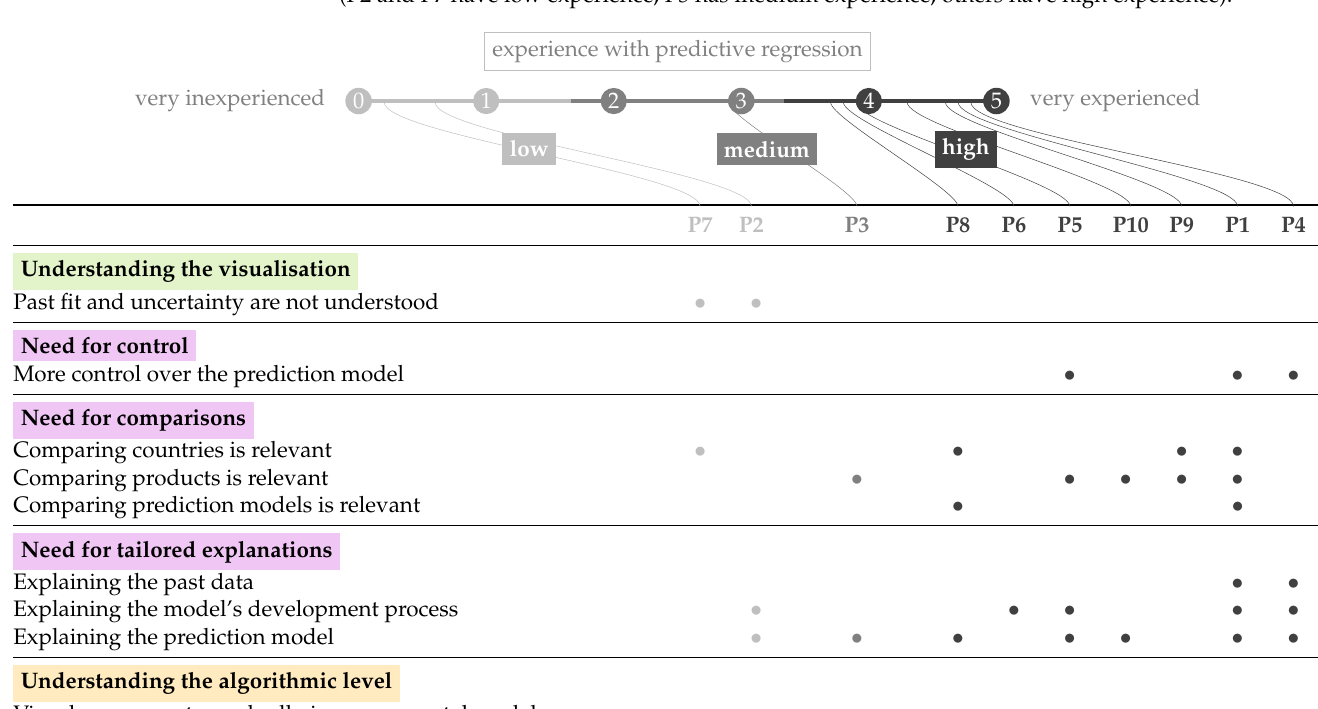
Table 2. Some topics raised by the participants, ordered by their experience with predictive regression (P2 and P7 have low experience; P3 has medium experience; others have high experience).